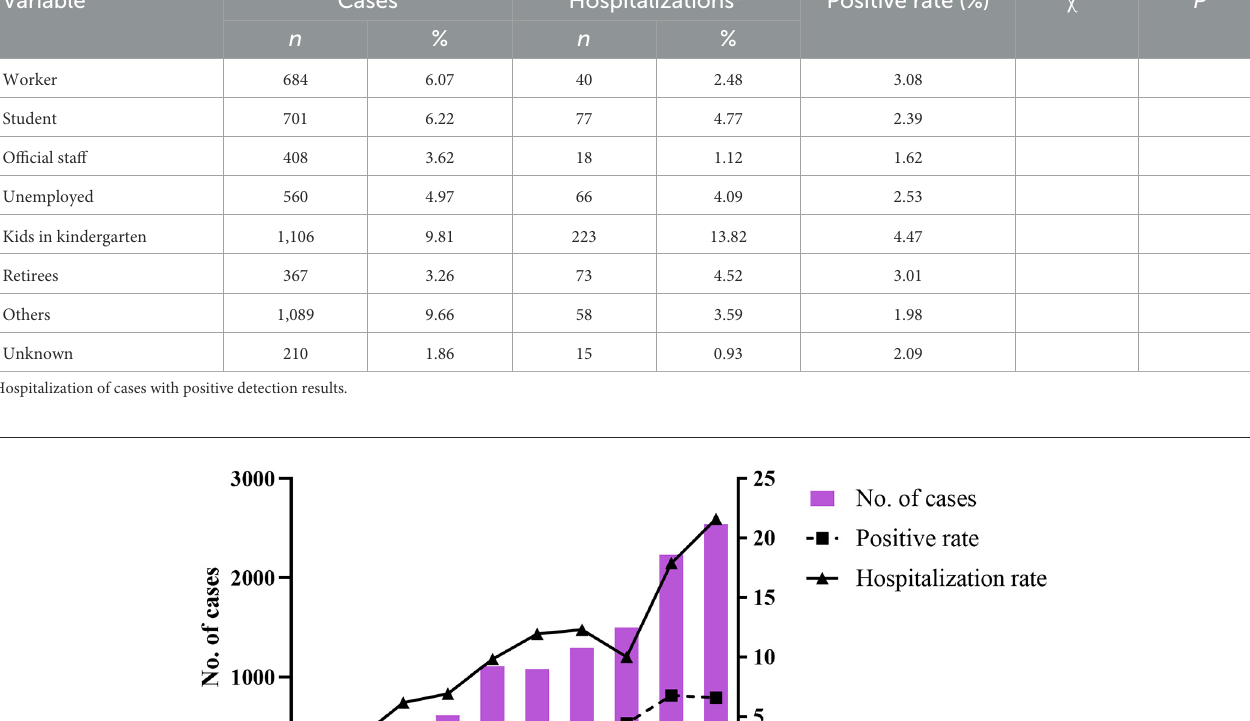
infection in the Zhejiang Province between 2012 and 2021. During the years, 11,269 cases with 1,614 (14.32%) hospitalizations were reported, corresponding to an average positive rate of 3.65% for the whole province. The average age of patients infected with Salmonella was 33.63 years. In all settings and food categories, Salmonella cases occurred most commonly in household settings (6,163 cases,